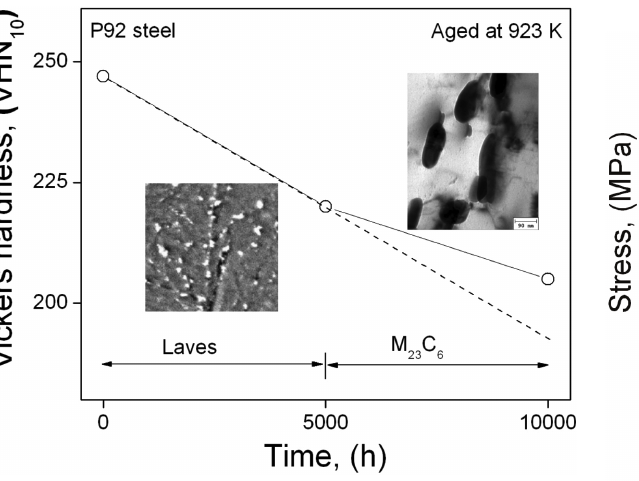
Figure 7: Tensile stress – strain curves of P92 steel in the normalized and tempered, and thermal aged at 923 K